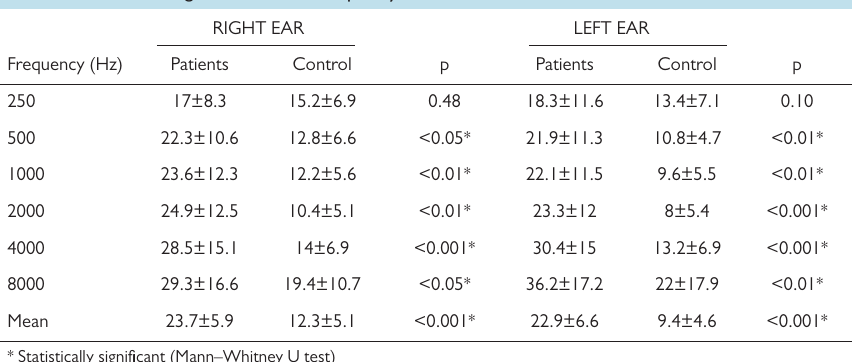
Table 2. Mean hearing levels for each frequency RIGHT EAR